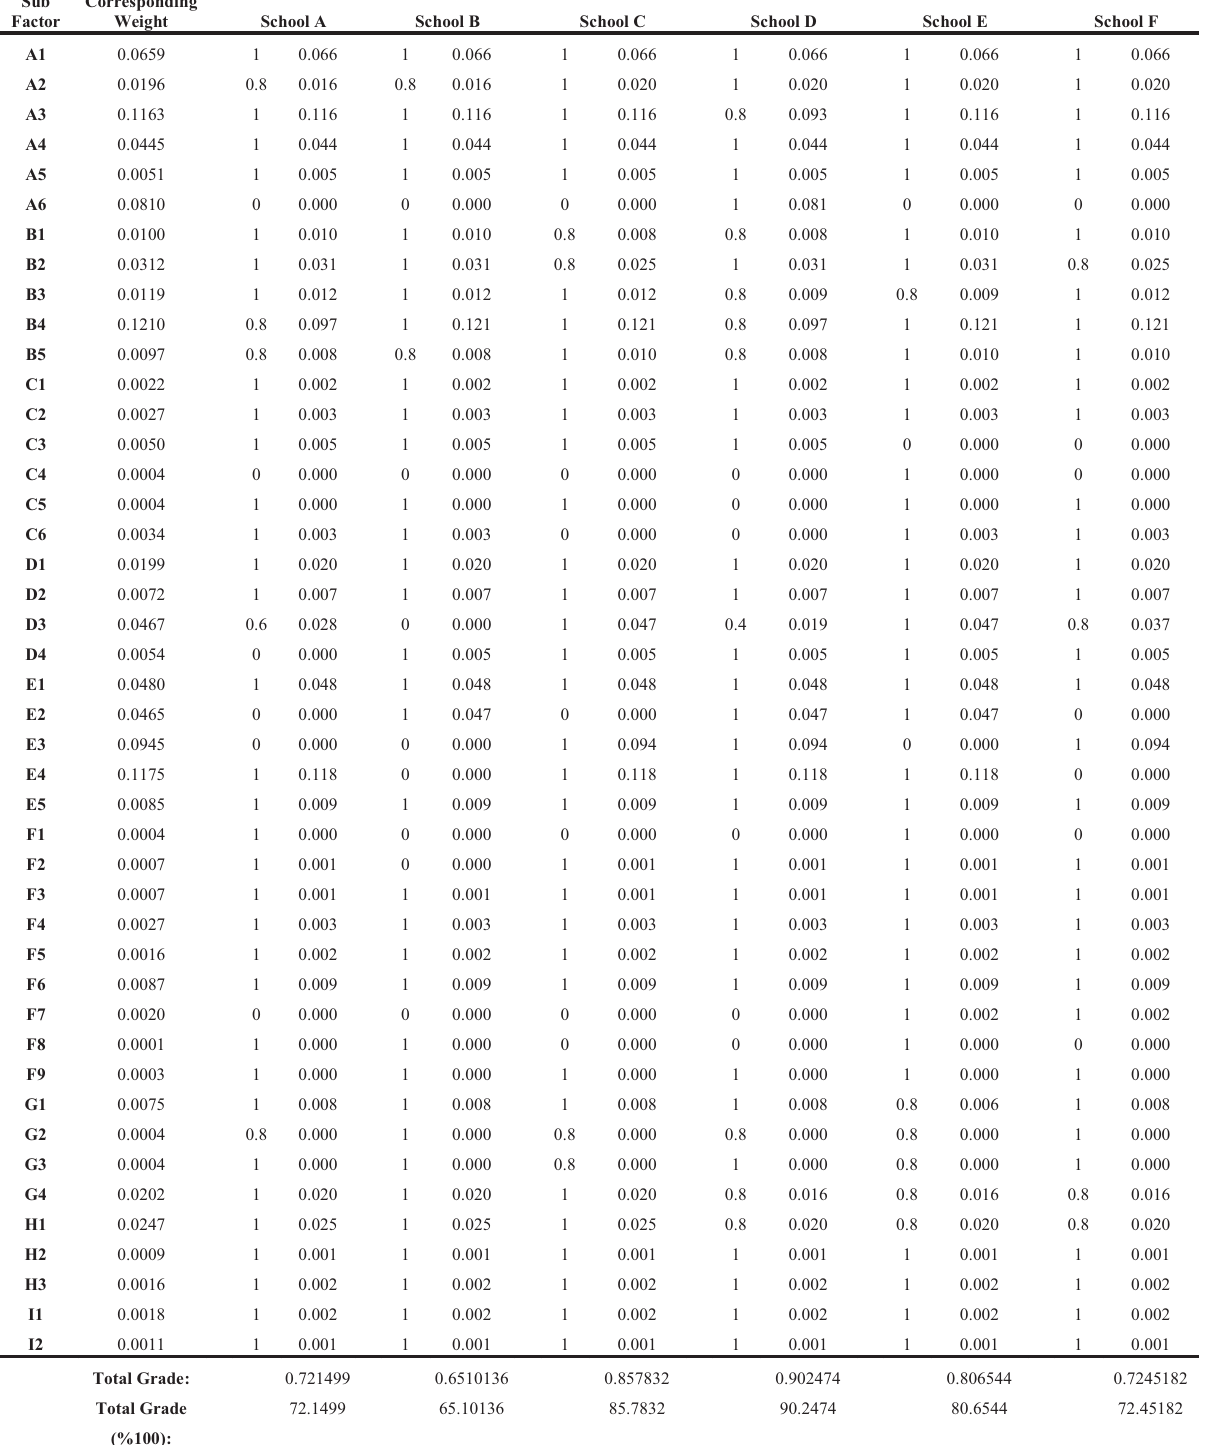
Table 11. Total grades of alternatives based on f ( x ) =